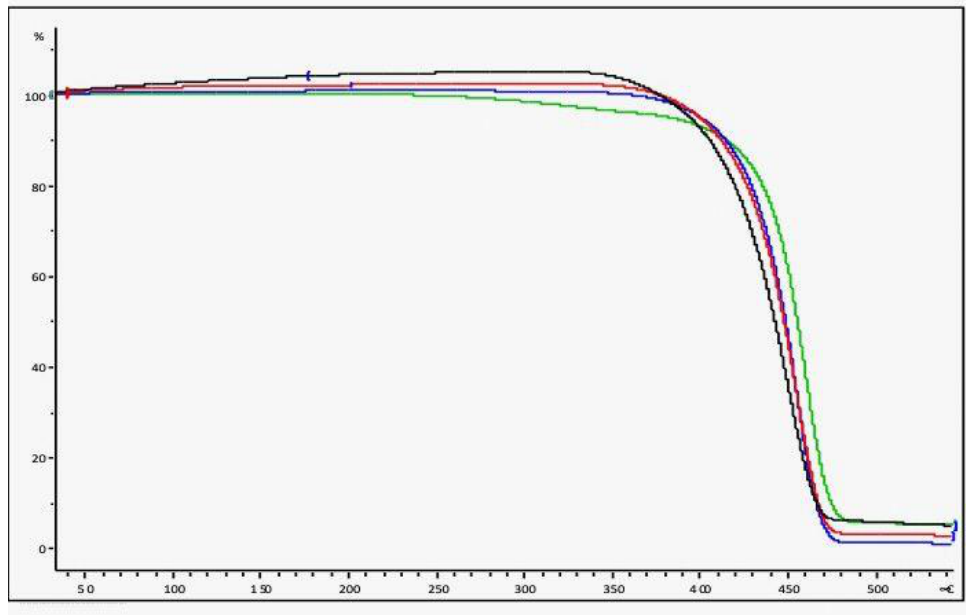
Figure 9. TGA analysis of the socks. Black= virgin PP, Red= treated with 30% H 2 O 2 , blue = treated with 30% HNO 3 , green = untreated socks.